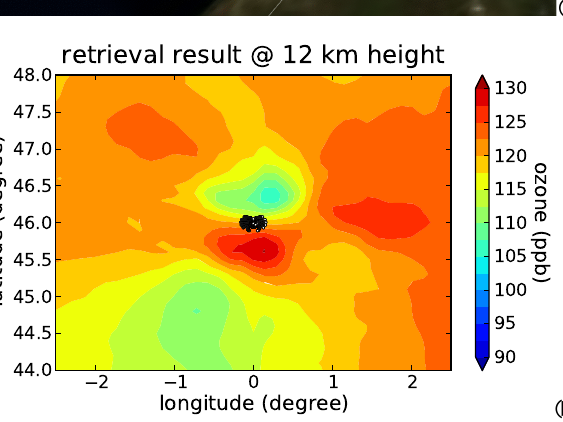
Fig. 8. The horizontal resolution in longitudinal direction of the baseline setup. (a) Shows the horizontal resolution at 12km altitude while (b) depicts the horizontal resolution at 46 ◦ N.